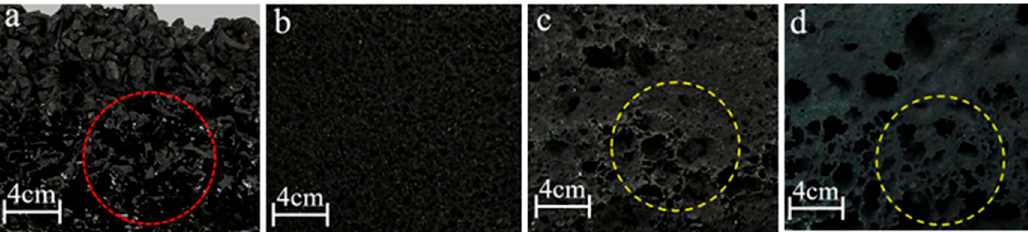
Figure 2. Effect of different BC particle sizes (( a ) 1700 µ m, ( b ) 270 µ m, ( c ) 149 µ m, ( d ) 74 µ m) on the formation of the composites.